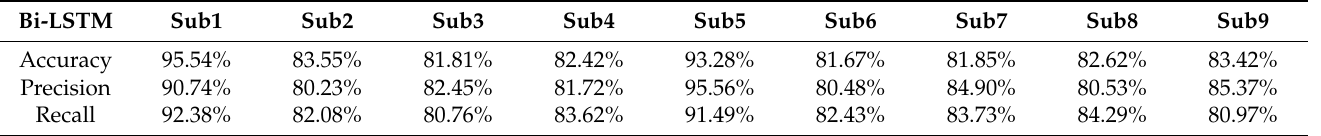
Table 4. Accuracy, precision and recall of deep learning (DL) algorithm, bidirectional LSTM (Bi-LSTM) for all nine subjects.